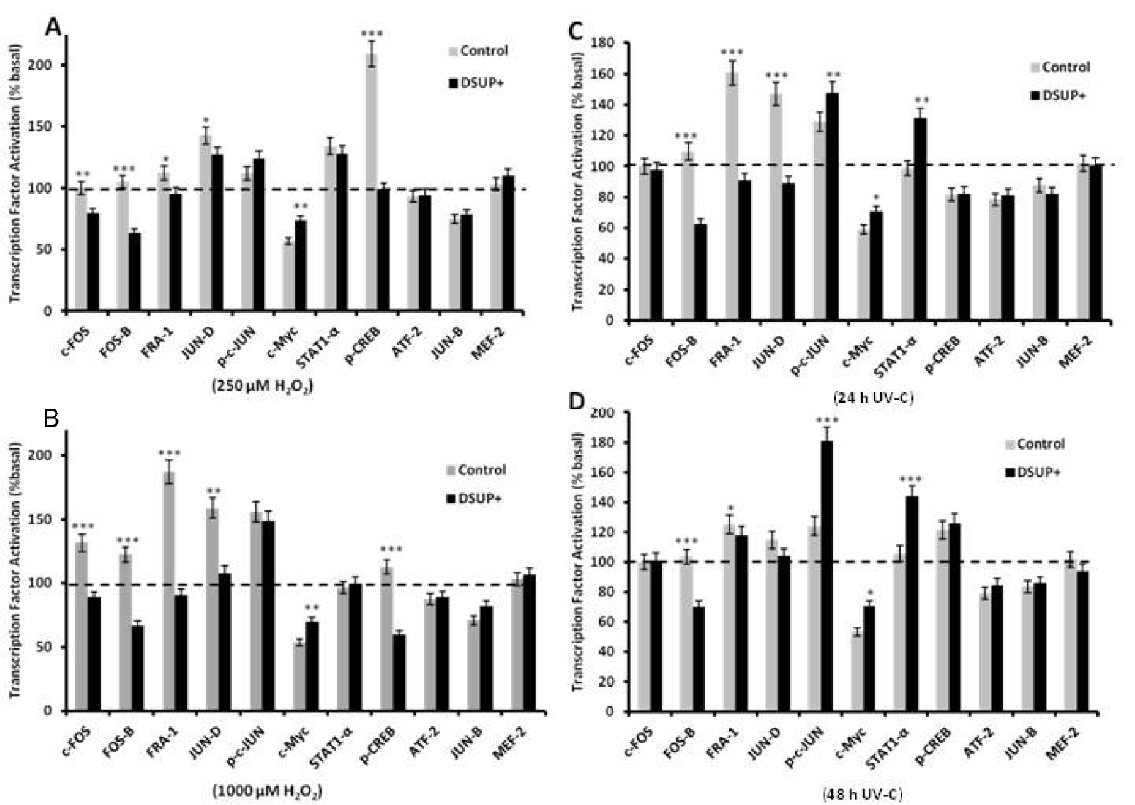
Figure 2. Transcription factor activation in Dsup+ and untransfected HEK293 (control) after 250 (panel A ) or 1000 (panel B ) µM H 2 O 2 O/N or 5 ″ UV-C exposure (panel C , 24 h of recovery and panel D , 48 h of recovery). Results are reported as percentage over basal condition (100% and dotted lines in figure). MAPK pathway (ATF2, p-c-Jun, c-Myc, MEF2, STAT1 α ), AP-1 family (c-Fos, FosB, FRA-1, p-c-Jun, JunB, and JunD) and CREB/p-CREB expression were evaluated by ELISA. * p < 0.5; ** p < 0.01; *** p < 0.001 by Wilcoxon signed-rank test. Each point is the mean of triplicate wells.